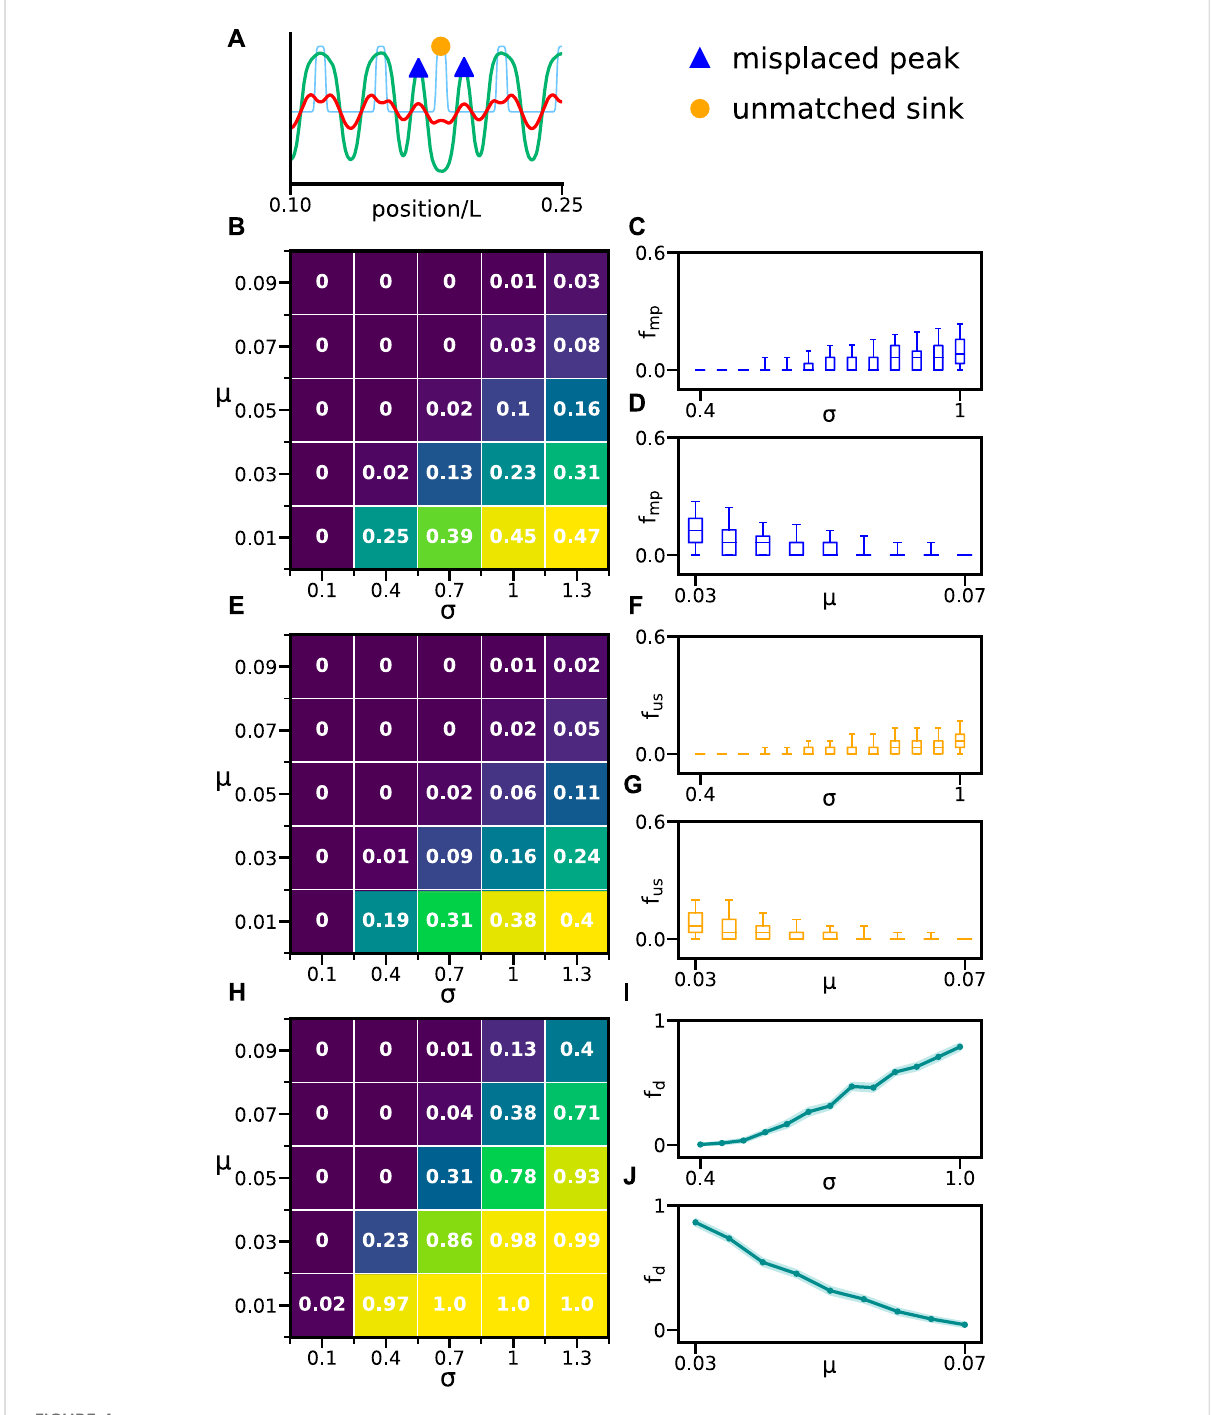
FIGURE 4 Effects of initial activity and noise in pattern formation. (A) Activator (green line), inhibitor (red line) patterns, and inhibitor sink pro fi le (light blue line)showingmisplacedpeaks(bluetriangles)andanunmatched sink(orangedot). (B) 〈 fmp 〉 fordifferentvalues of μ and σ . (C) fmpvs. σ for fi xed μ = 0.05. (D) fmpvs. μ for fi xed σ =0.7. (E) 〈 fus 〉 fordifferentvaluesof μ and σ . (F) fusvs. σ for fi xed μ =0.05. (G) fusvs. μ for fi xed σ =0.7. (H) fdfor different values of μ and σ . (I) fd vs. σ for fi xed μ = 0.05. (J) fd vs. μ for fi xed σ = 0.7. (I and J) Errors in fd (dark cyan shade) are the standard deviation determined using a statistical bootstrap. (C,D,F, and G) Middle line marks the median, box limits are 25 and 75 percentiles, and whiskers are 5 and 95percentiles. Brackets 〈 . 〉 denoteaverage overrealizations.Otherparameters are as inTable 1.In all cases, we performed 300realizationsfor each parameter